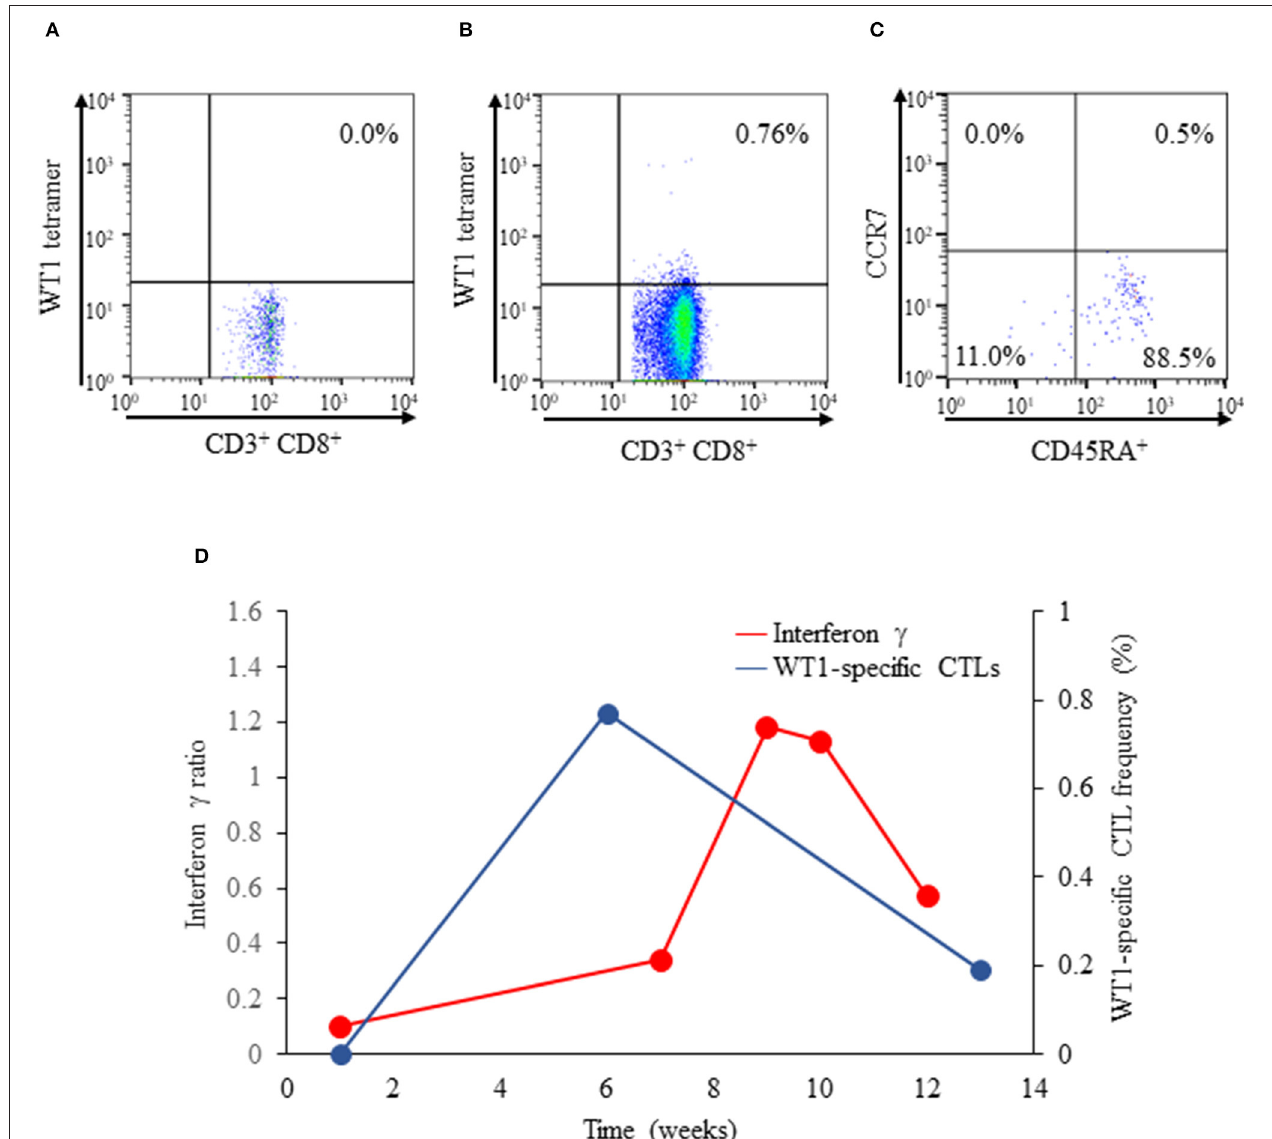
FIGURE 2 | Flow cytograms of WT1-specific CTLs obtained with a flow cytometer (BD FACSCanto TM II). (A) WT1 tetramer + CD8 + T cells did not emerge at the onset of vaccination (proportion of WT1 tetramer + CD8 + T cells: 0.0%). (B) WT1-specific CTLs emerged at week 6 of vaccination (proportion of WT1 tetramer + CD8 + T cells: 0.76%). (C) Diagram showing the phenotypes of WT1-specific CTLs: effector T cells (CD45RA + CCR7 − : 88.5%), effector memory T cells (CD45RA − CCR7 − : 11.0%), naïve T cells (CD45RA + CCR7 + : 0.5%), and central memory T cells (CCR7 + , CD45RA − : 0.0%). (D) Interferon γ ELISpot assay of PBMCs. Isolated PBMCs were stimulated with WT1-235n (natural peptide: aa 235–243 CMTWNQMNL). The stimulated-to- unstimulated PBMC spot ratio was calculated. Interferon γ production by WT1-specific CTLs was considered positive when the ratio was > 1. The frequencies (%) of WT1-specific CTLs at weeks 1 to 13 of vaccination are plotted. WT1, Wilms tumor 1; CTLs, cytotoxic T cells; PBMCs, peripheral blood mononuclear cells.